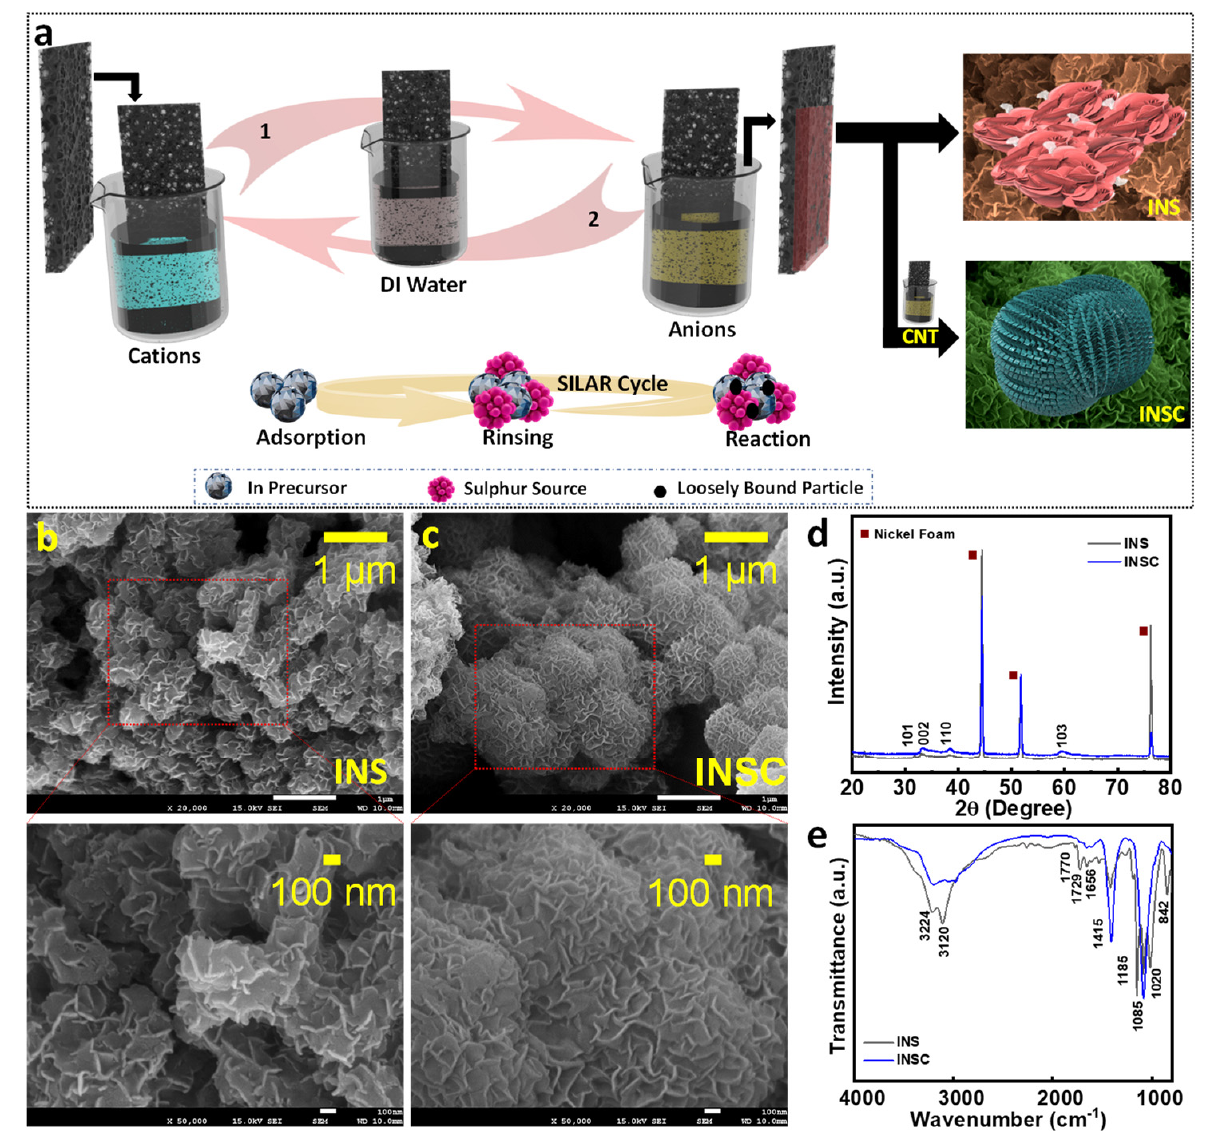
Figure 1. ( a ) Schematic illustration of synthesis of sample INS and INSC, FE-SEM images of sample ( b ) INS, ( c ) INSC, ( d ) XRD pattern (missing is the JCPDS file), and ( e ) FTIR spectra of as-prepared electrode materials INS and INSC.